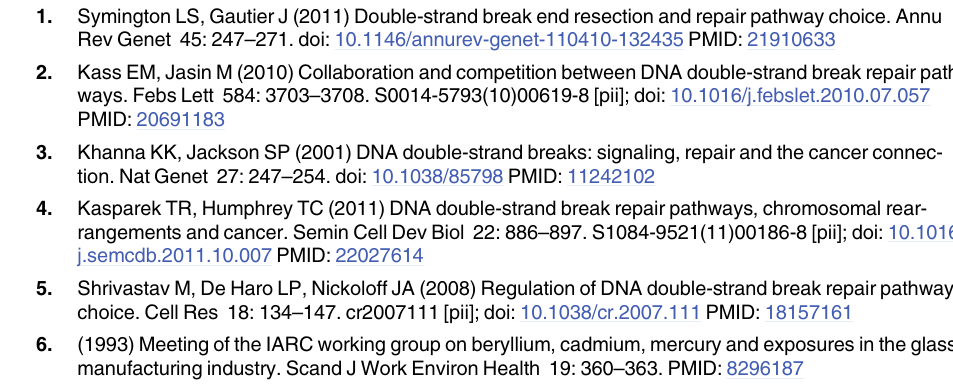
S6 Table. AARP cassette